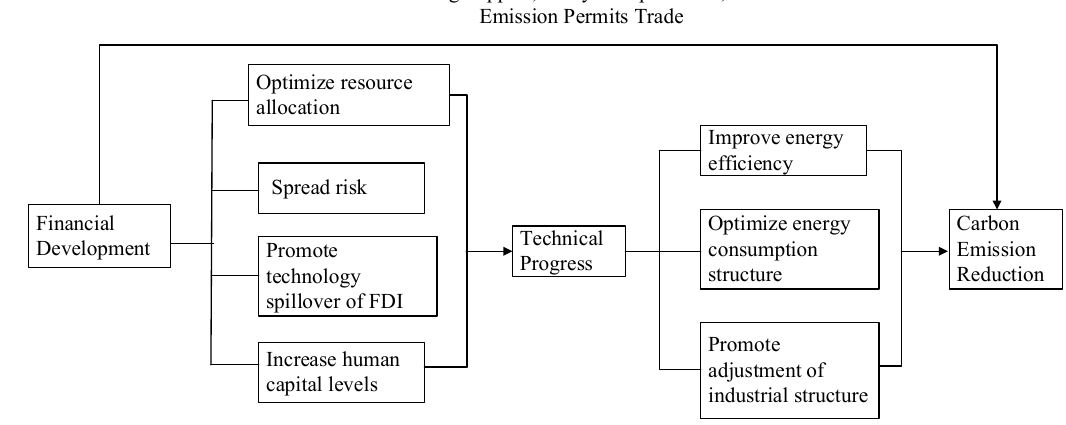
Figure 1. Path analysis of financial development affecting carbon emission reduction.